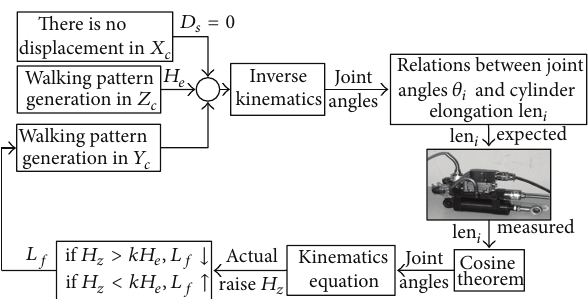
Figure 5: Diagram of the motion adjustment in 𝑌 𝑐